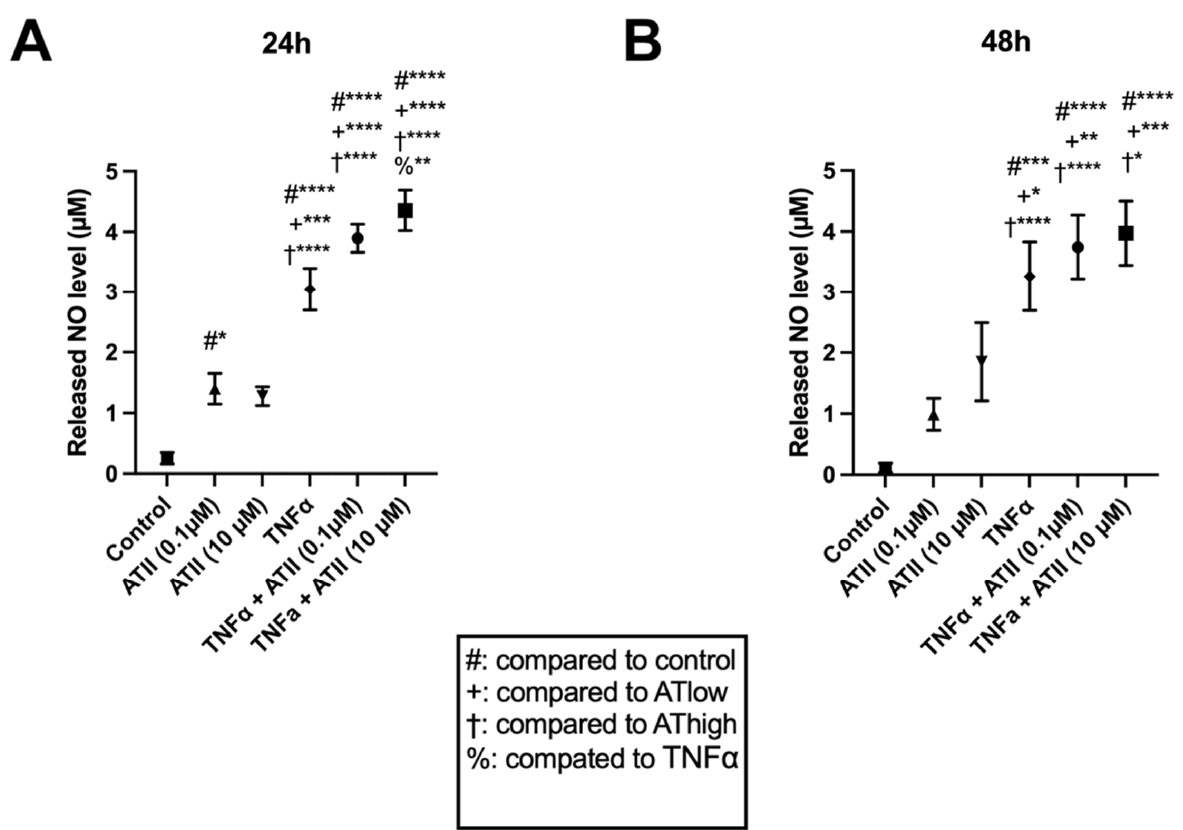
Figure 4. Illustration of indirect nitric oxide (NO 2 ) concentrations in the medium for the study groups after 24 h ( A ) and 48 h ( B ) of drug/control exposure. Nitric oxide was measured indirectly from nitrite release from the metabolism of nitric oxide. n = 4 biological replicates and n = 3 technical replicates per donor were assessed. Mean and standard error of the mean (SEM) are shown. #,* p < 0.05; ** p < 0.01; *** p < 0.001; **** p < 0.0001.